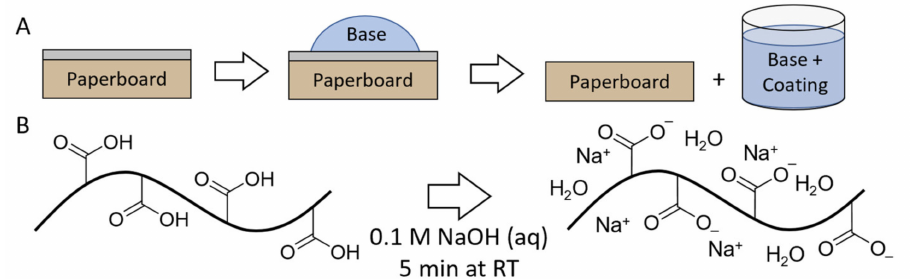
Figure 4. ( A ) Schematic representation of the base treatment of the waterborne coating. ( B ) Schematic depiction of the influence of base (0.1 M NaOH) on the carboxylic acids of the ASR causing deprotonation.